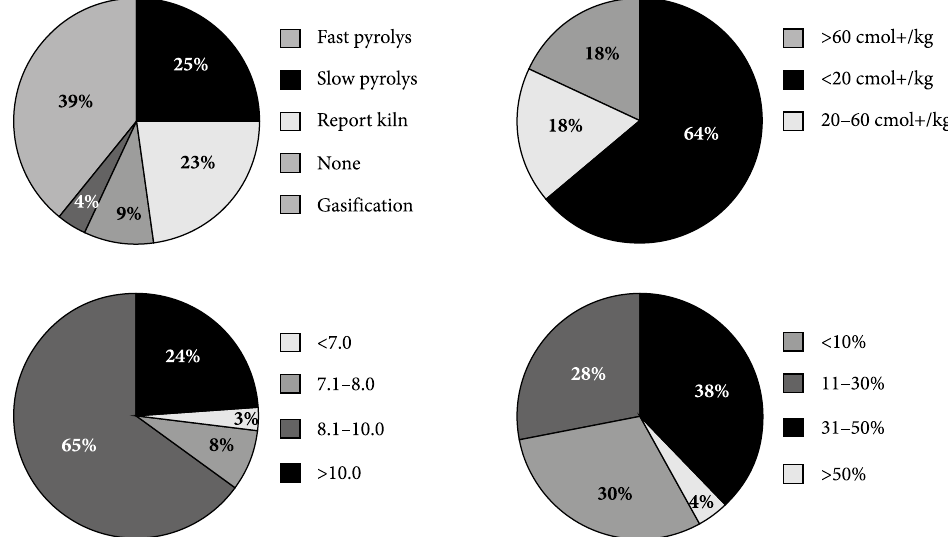
Fig. 2. Overview of biochar production technologies and main biochar properties in Europe (Feb. 2015): Production technology (top left, n = 67); biochar CEC (top right, n = 11); biochar pH (bottom left, n = 62); biochar ash content (bottom right, n =